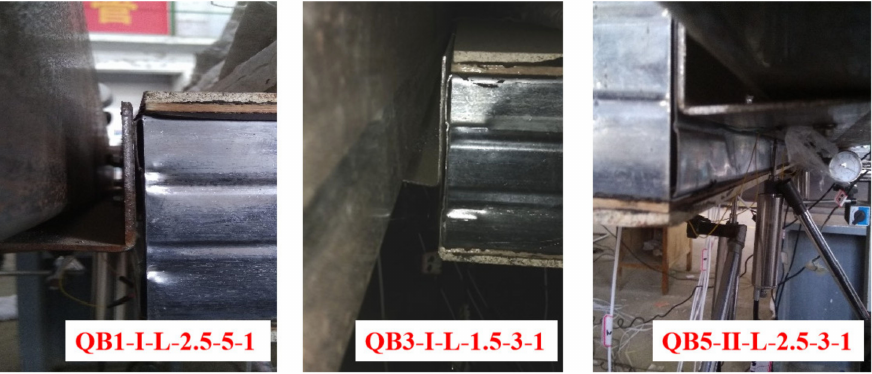
Figure 10. Deformation of continuous L-shaped connectors under applying maximum load.